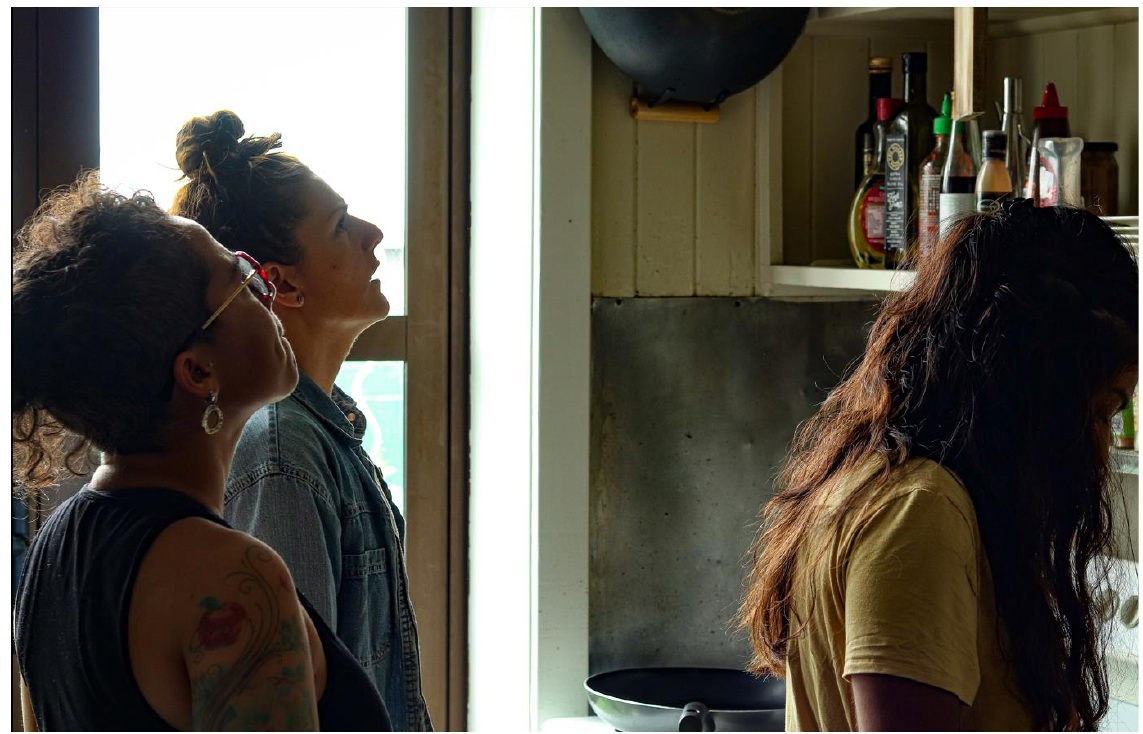
Figure 1: Janaína Moraes and Dancers. FAR – Flash Art Residency, Auckland,